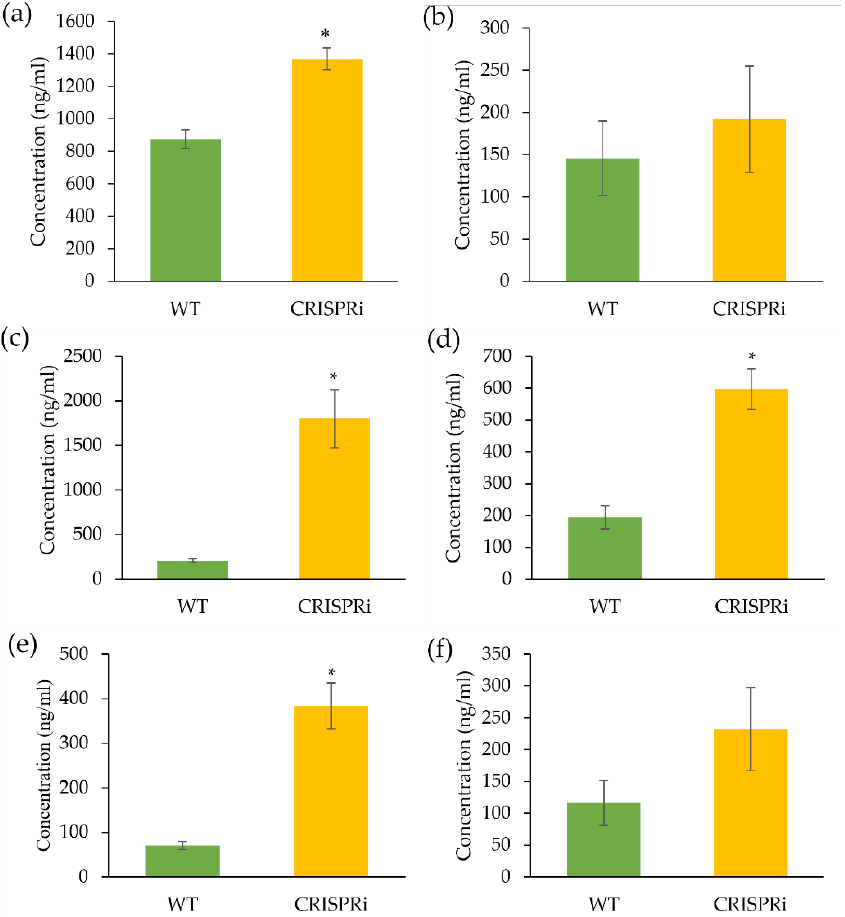
Figure 5. Concentration of selected compounds in wild type (WT) and transgenic CRISPRi cell lines of Nicotiana tabacum cell suspension cultures. ( a ) Cinnamic acid, ( b ) p -coumaric acid, ( c ) chlorogenic acid, ( d ) naringenin, ( e ) pinostrobin, and ( f ) kaempferol. Data represent the means of three biologi- cal replicates (n = 3). Error bars are standard deviation (±SD). Asterisk (*) represents significant differences at p < 0.05 according to paired t -test.